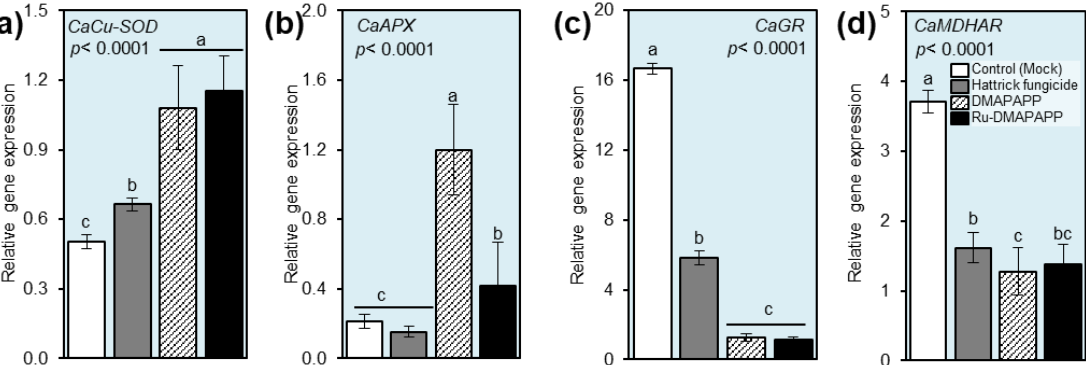
Figure 8. Effect of two bis-chalcone derivatives, DMAPAPP and Ru-DMAPAPP, on gene expression of major antioxidant defense-related enzymes associated with fusarium wilt disease caused by Fusarium equiseti on pepper plants under greenhouse conditions. ( a ) Relative gene expression of superoxide dismutase [Cu-Zn] 1 ( CaCuSOD ), ( b ) relative gene expression of cytosolic ascorbate peroxidase 1 ( CaAPX ), ( c ) relative gene expression of glutathione reductase, chloroplastic ( CaGR ), and ( d ) relative gene expression of monodehydroascorbate reductase ( CaMDHAR ). Values represent the means ± standard deviations (means ± SD). Different letters indicate statistically significant differences between treatments using the Tukey – Kramer honestly significant difference test (Tukey HSD; p < 0.05). Table 1. Growth parameters on pepper plants 60 days after transplanting.